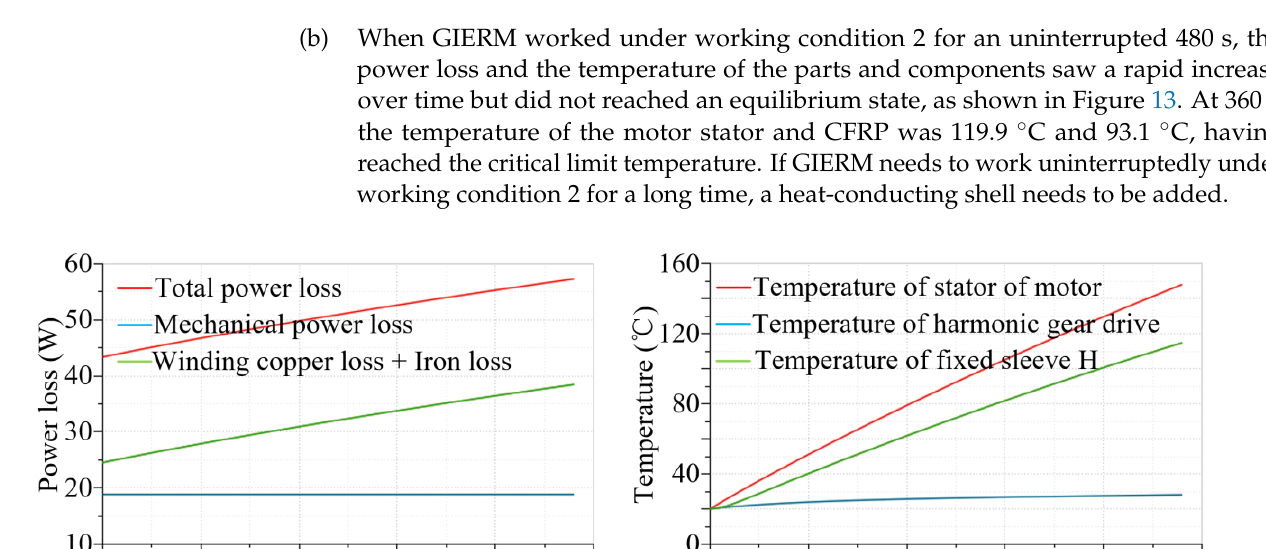
Figure 13. Variation of power loss and temperature over time (without the heat-conducting shell).